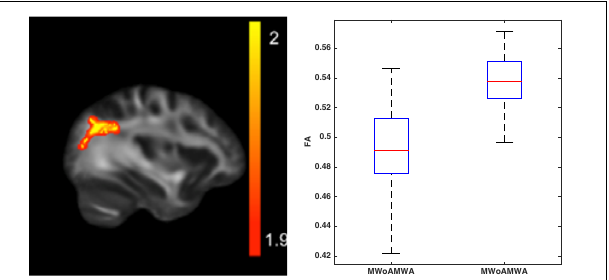
TABLE 1 | Demographic and clinical data.